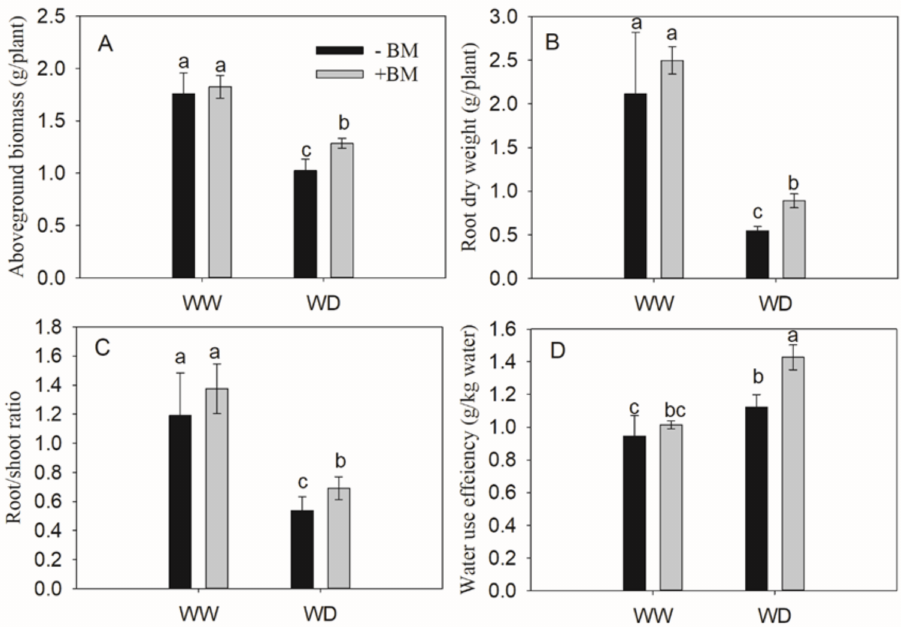
Figure 5. Effect of BM application on plant biomass ( A ), root biomass ( B ), root/shoot ratio ( C ) and water-use efficiency ( D ) of ryegrass under two water status. The well-watered control (WW) and water-deficit (WD) show the different soil water contents. The different letters indicate significant difference ( p <